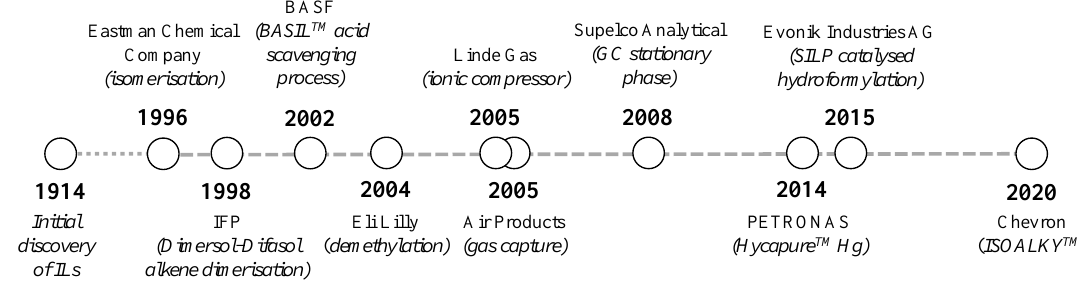
Figure 4. Development of commercialised IL-based processes.